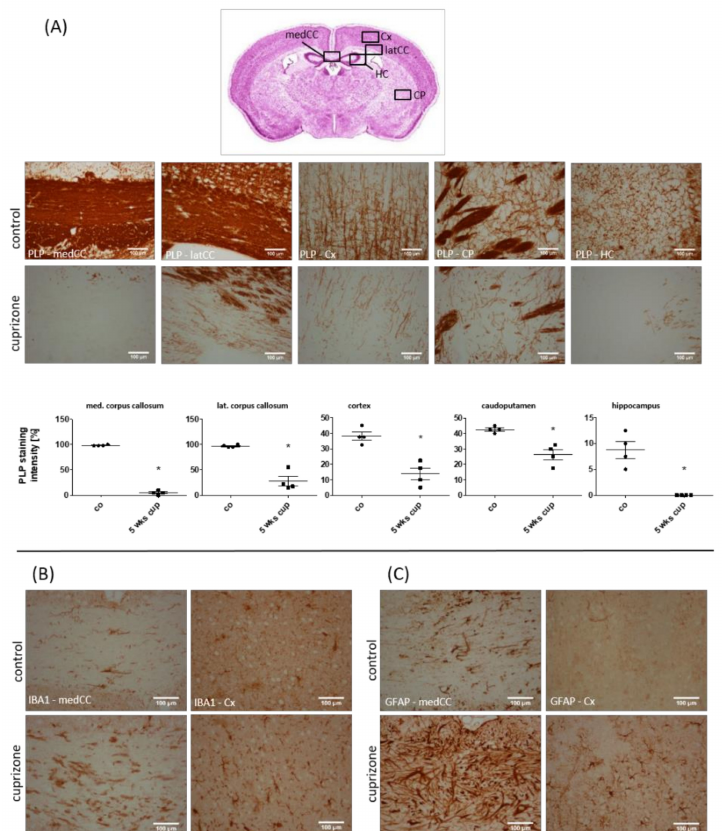
Figure 1. Cuprizone-intoxication induces multifocal demyelination and reactive glia activation. ( A ) The myelination of different brain areas, determined by anti-PLP staining. The upper row shows representative pictures of the control ( n = 4), and the lower row shows representative pictures of the cuprizone-intoxicated animals (5 weeks; n = 4). ( B ) Cuprizone-induced demyelination is paralleled by microglia activation (shown with IBA1 immunoreactivity; n = 4), and ( C ) astrocyte activation (shown with GFAP immunoreactivity; n = 4). medCC (medial part of the corpus callosum); latCC (lateral part of the corpus callosum); Cx (cortex); CP (caudoputamen); HC (hippocampus). Differences were determined using Mann–Whitney tests. * p < 0.05, ** p < 0.01, and *** p <